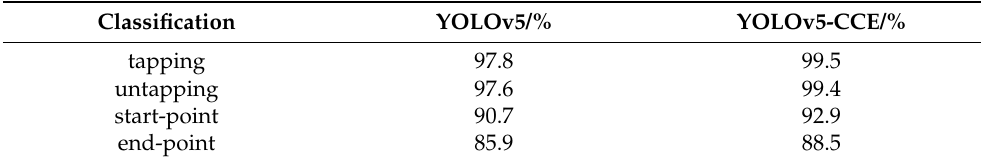
Table 4. Results of mAP (0.5) of each